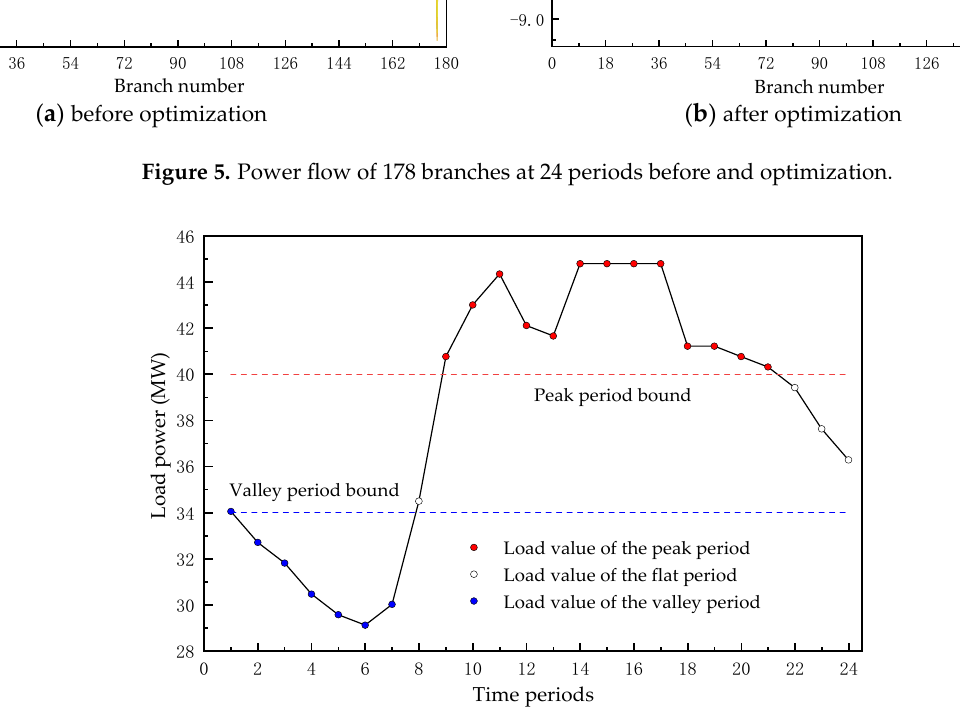
Figure 6. Total load curve at 24 time periods.